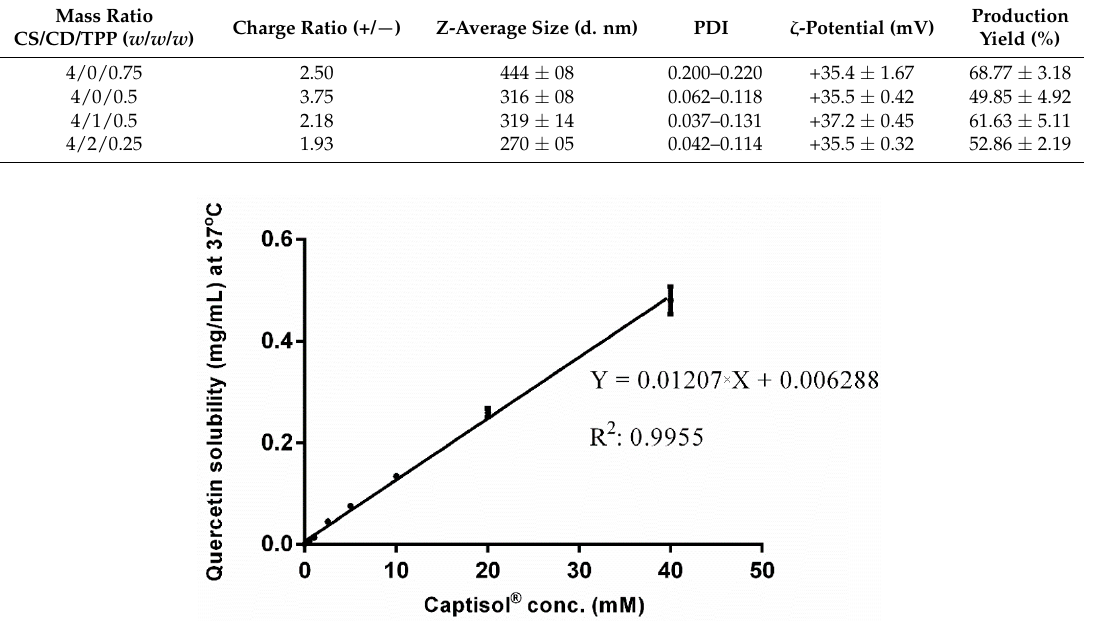
Figure 3. Phase solubility of quercetin in the presence of increasing concentration of SBE β CD. Table 4. Physicochemical properties of CS 70/20 /SBE β CD/TPP quercetin-loaded nanoparticles (mean ± S.D., n = 3).